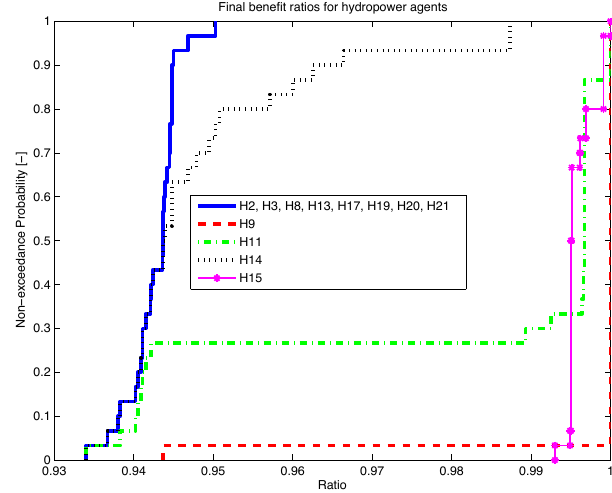
Figure 14. Final benefit ratio for hydropower